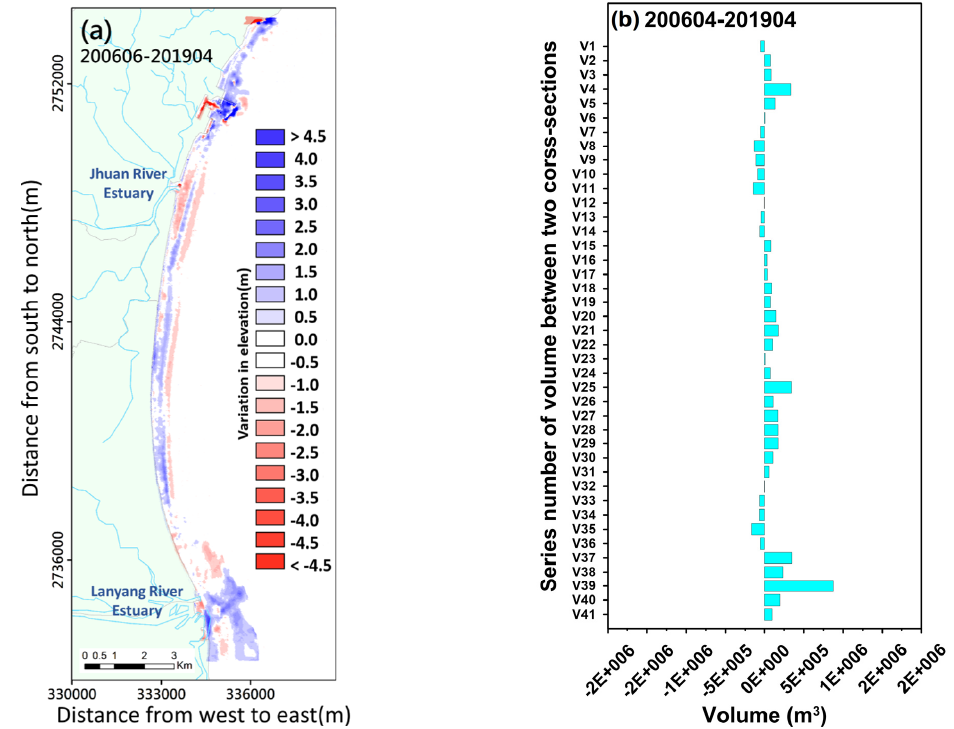
Figure 7. The erosion and accretion volume between each pair of cross sections during the period of (a) June 2006 to April 2013 and (b) April 2013 to April 2019.